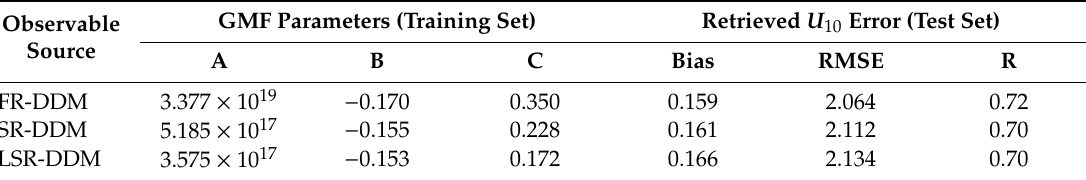
Table 3. U 10 retrieval algorithm performance statistics. Bias and root-mean-square errors (RMSEs) are expressed in m / s. Pearson’s R is also